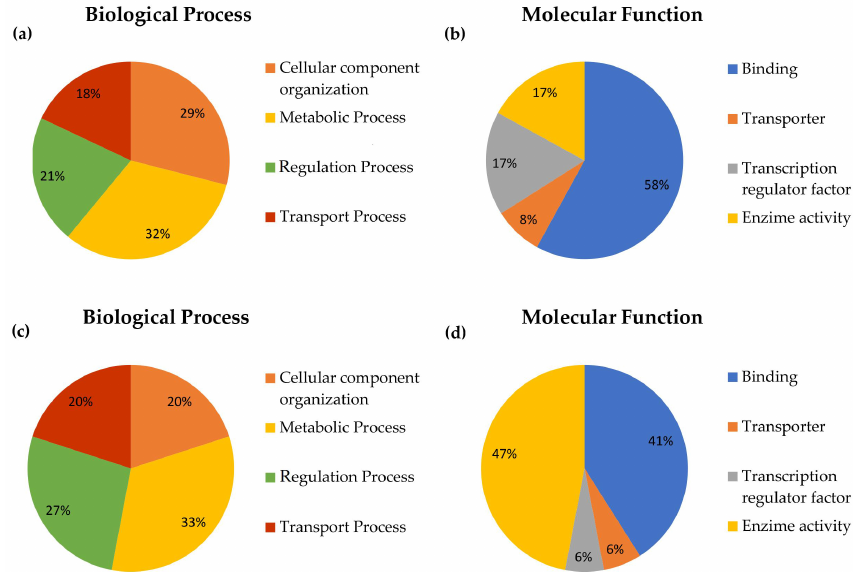
Figure 4. Percentage of di ff erential gene expressions (DGEs) involved in the di ff erent biological processes and molecular functions, as reported in gene ontology (GO) term analysis, for both types of signals evaluated. ( a ) Percentage of genes involved in each biological process after exposure to 2.45 GHz CW. ( b ) Percentage of genes involved in each molecular function after exposure to 2.45 GHz CW. ( c ) Percentage of genes involved in each biological process after exposure to 2.45 GHz PW. ( d ) Percentage of genes involved in each molecular function after exposure to 2.45 GHz PW.